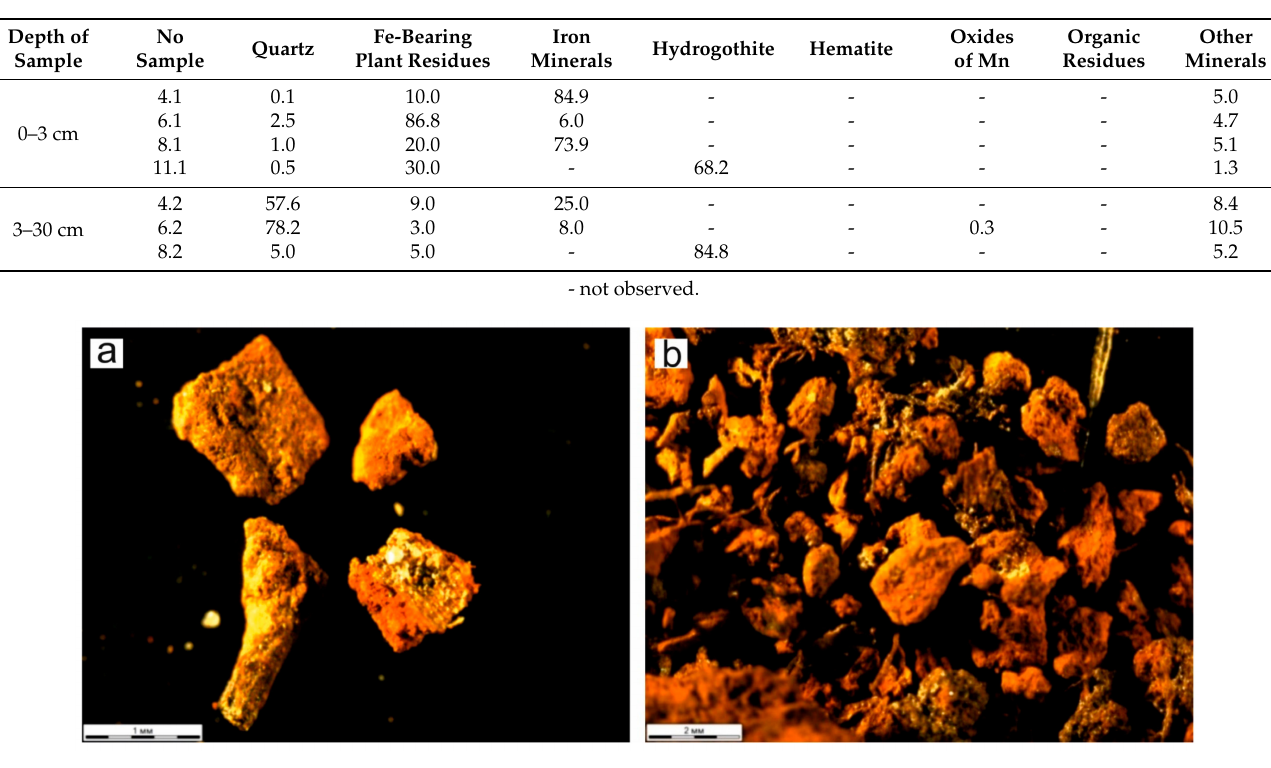
Figure 10. Images of iron-bearing phases: ( a ) Fe-bearing plant residues; ( b ) Fe-bearing minerals. The scanning electron microscope images of the reddish-yellow iron-rich precipitates on the surface of upper soil horizon showed cubic halite crystals, flaky particles, a crust of iron oxides-hydroxides (Figure 11) and spongy residues. The spongy siliceous residues are remains of diatoms and are enriched in Ca, Fe, Cl, K, Na, S, and P (Figure 12).